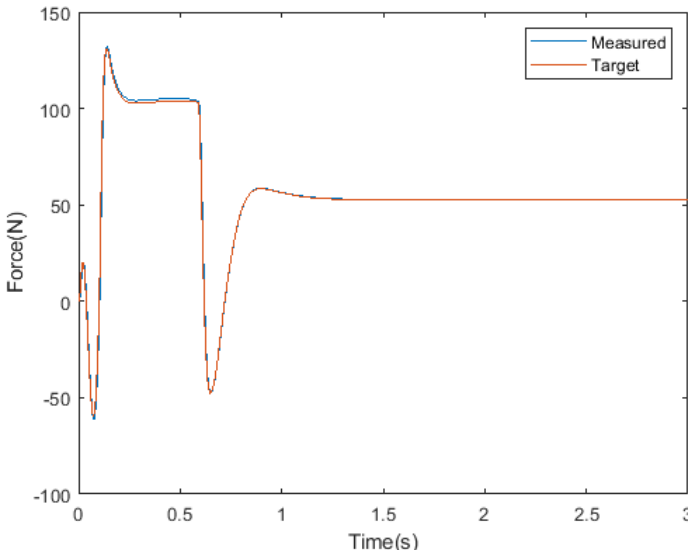
Figure 16. Measured and desired force.